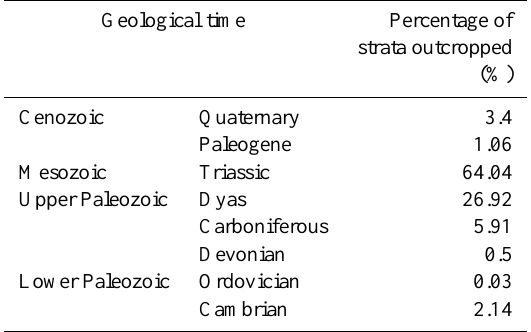
Table 2. Quantity of all types of strata outcropped in the study area. Geological time Percentage of strata outcropped (%) Cenozoic Quaternary 3.4 Paleogene 1.06 Mesozoic Triassic 64.04 Upper Paleozoic Dyas 26.92 Carboniferous 5.91 Devonian 0.5 Lower Paleozoic Ordovician 0.03 Cambrian